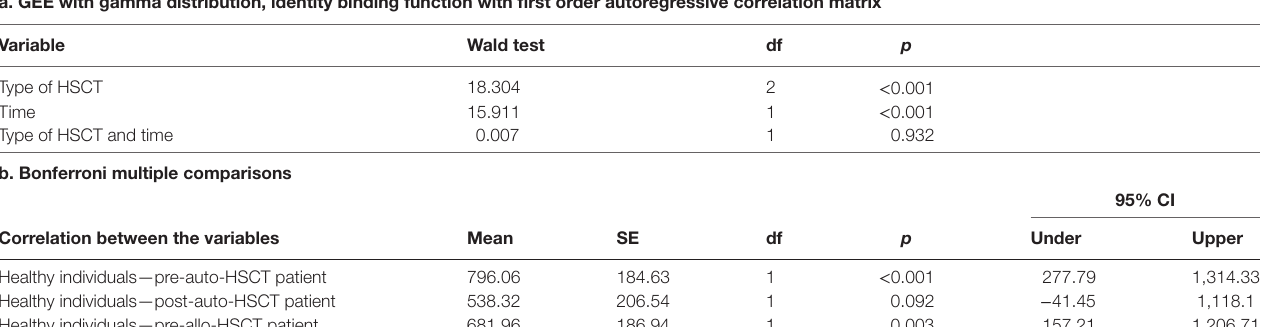
Table 5 | Correlation between types of HSCT (auto- and allo-) and time (pre-HSCT to the ninth month post-HSCT). a. gee with gamma distribution, identity binding function with first order autoregressive correlation matrix